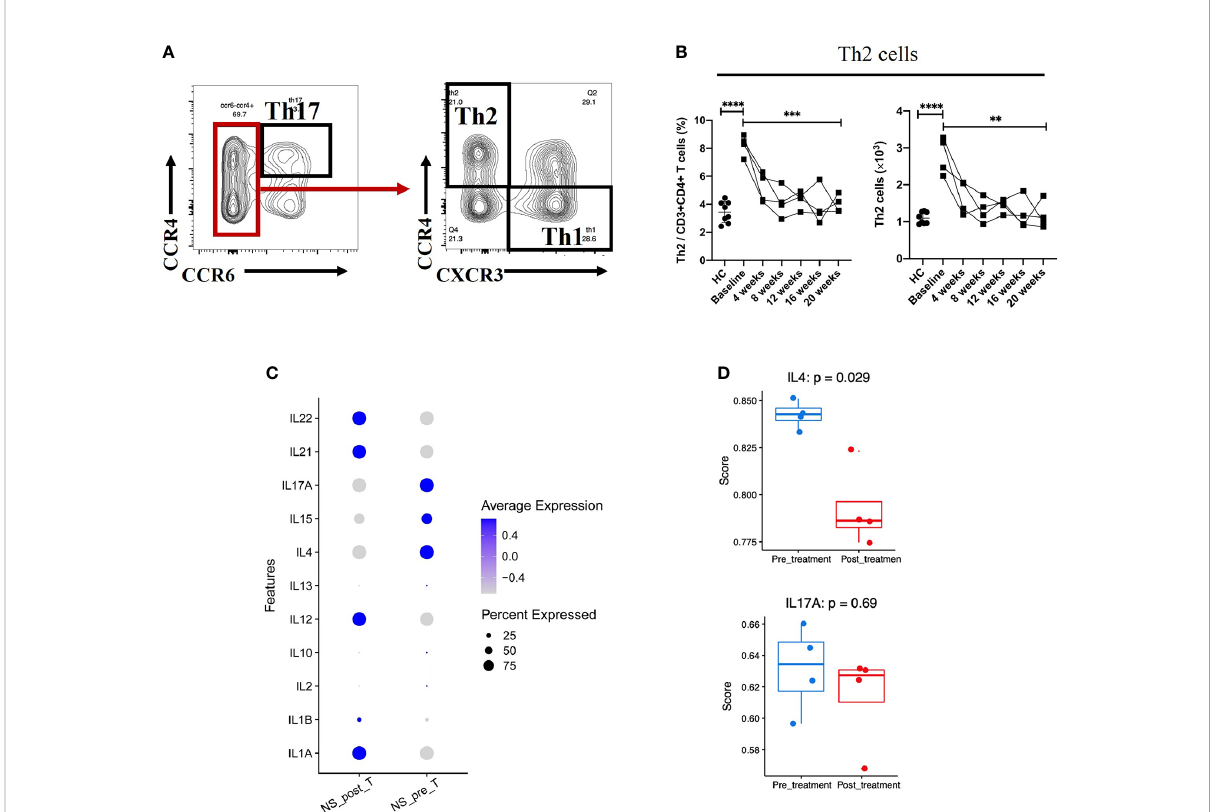
FIGURE 3 Reduction in Th2-mediated in fl ammation after 20 weeks of dupilumab treatment (A) Gating strategy used to identify Th2 and Th17 cells. (B) Changes in the percentages of Th2 cells among the CD3+CD4+ T cell population and in the absolute number of Th2 cells from baseline to 20 weeks of dupilumab treatment. (C) Dot plot illustrating (the top 11/select key) cytokine expression signatures/patterns of T cells before (pre) and 20 weeks after (post) dupilumab treatmentthe color intensity indicates the relative expression level and the size of the dots represents the percentage of cells expressing the cytokine genes across T cell subsets. (D) Quantitative scatter plot with a bar graph revealed the expression level of IL-4 and IL-17A in T cells across treatment conditions. The Wilcoxon matched pairs signed rank test or the Mann-Whitney U test was used to assess statistical signi fi cance: ****P < 0.0001; ***P < 0.001; **P < 0.01. Each dot represents a value for each